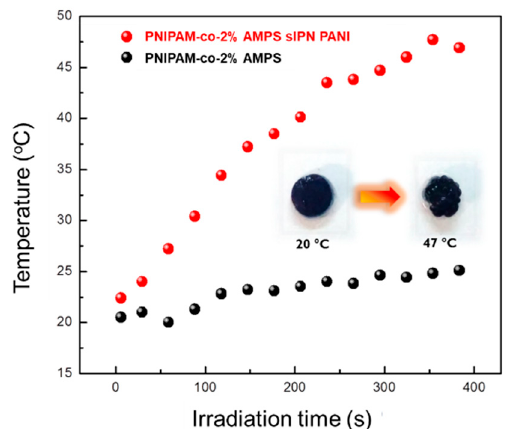
Figure 6. Measurements of temperature (red spheres) of a material (sIPN of PANI in PNIPAM-co-2% AMPS made by AMH) subjected to RF (1000 W, 30 kHz) irradiation. For comparison, the temperature of the hydrogel matrix (black spheres) during irradiation is shown. The temperature was measured using a thermographic camera. In the insert, the optical photographs of the ER-T-MCh material before (20 °C) and after 400 s of irradiation (47 °C) are shown.